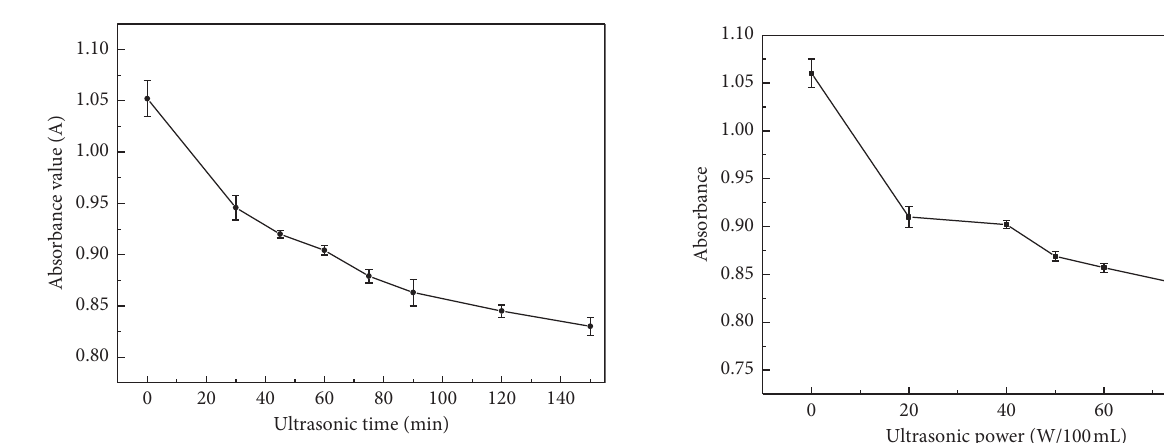
Figure 4: The maximum absorption intensity (664 nm) of the methylene blue solution in the UV-visible light varies with the ultrasonic